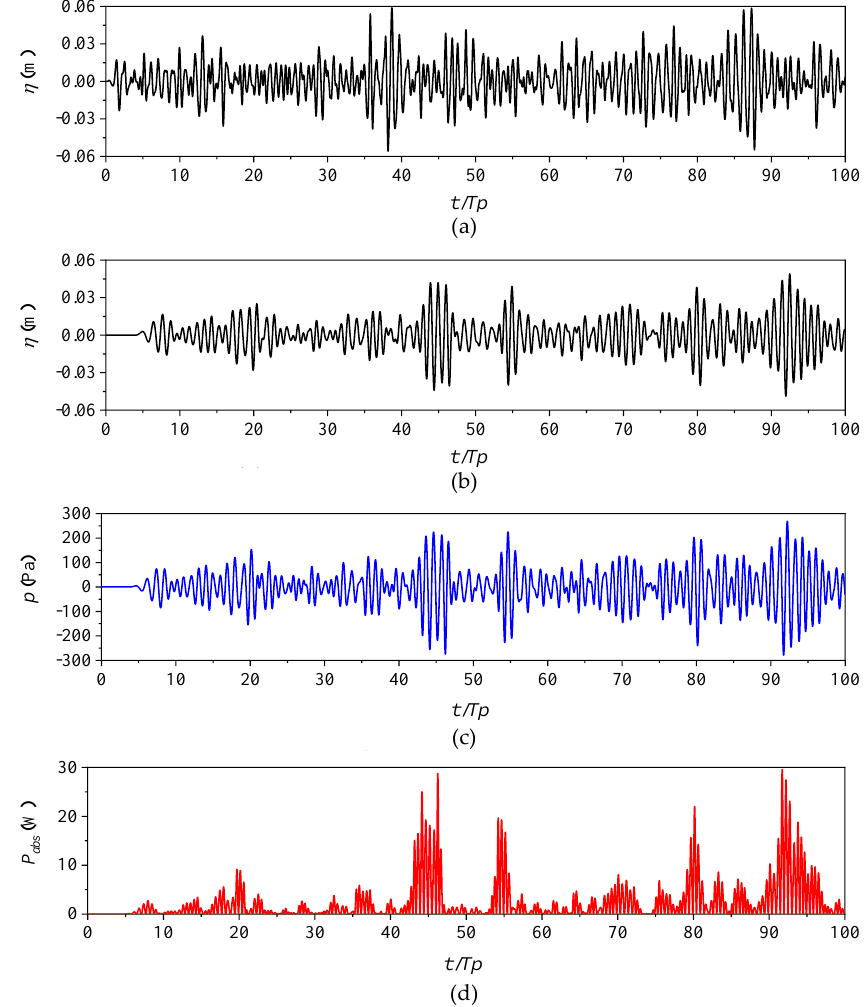
Figure 6 . Time histories of key hydrodynamic performance parameters at T p = 1.545 s. ( a ) incident wave elevation, ( b ) Surface elevation at chamber center, ( c ) Pneumatic pressure, ( d ) Pneumatic power. Table 1. Statistical characteristic value of wave parameters at H s = 0.06 m, T p = 1.545